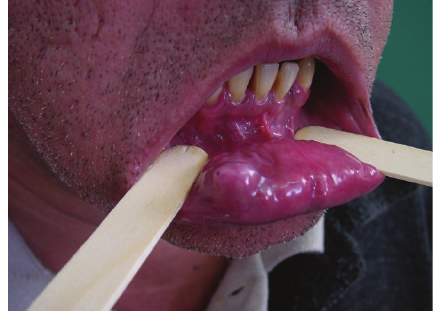
Figure 1: The bullous lesion of soft consistency characterized by the presence of a fistula in the mucosal surface and increased volume is shown.